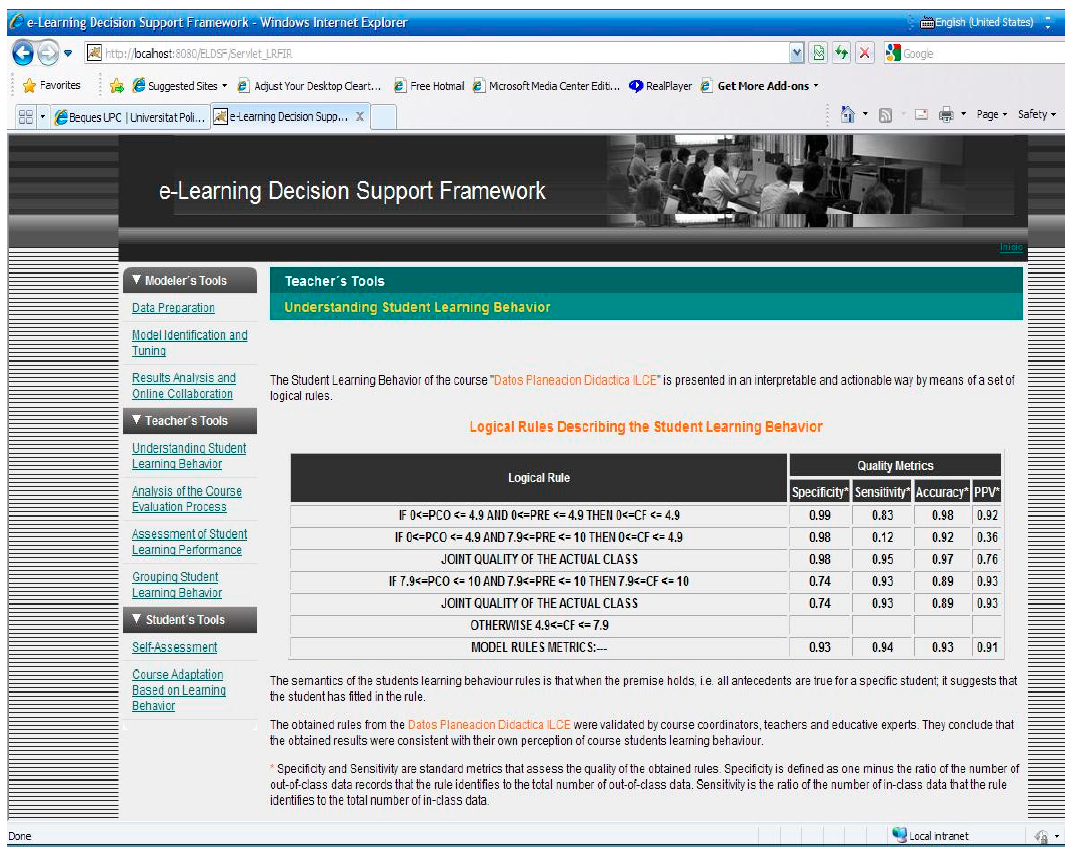
Figure 1. The e-Learning toolbox framework.